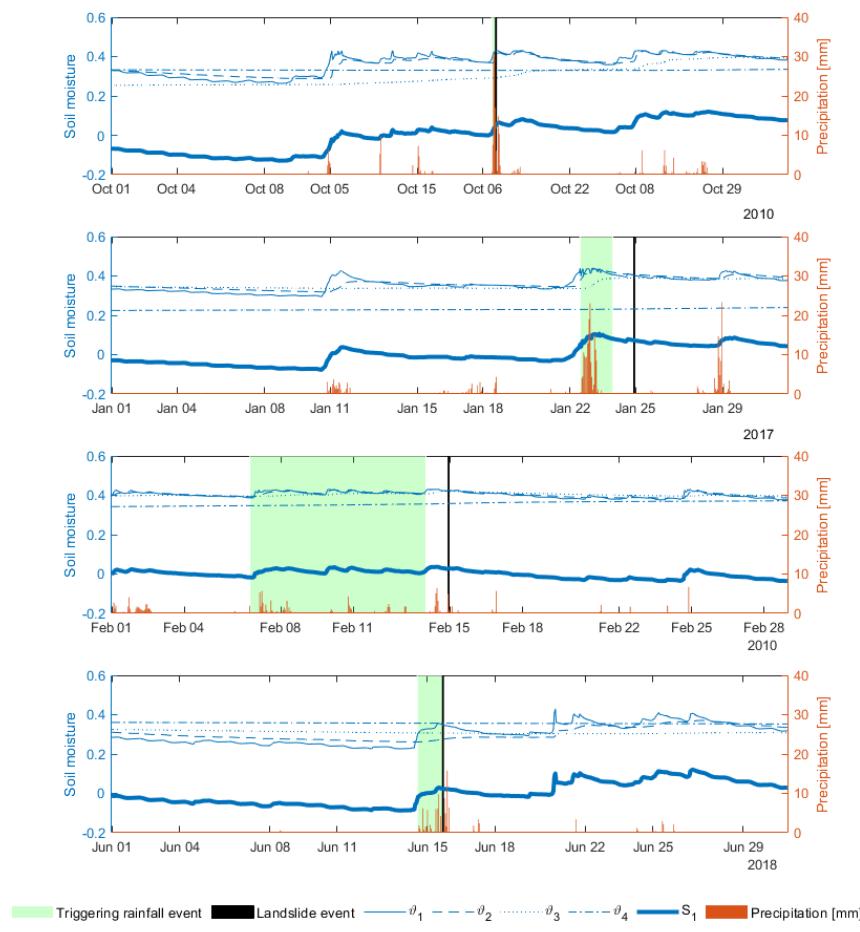
Figure 6. Panel showing four different triggering rainfall events. For each of them the precipitation time series together with the soil moisture time series ( ϑ 1 , ϑ 2 , ϑ 3 , ϑ 4 ) are reported, as well as the first principal component of soil moisture S 1 and the timing of each landslide.